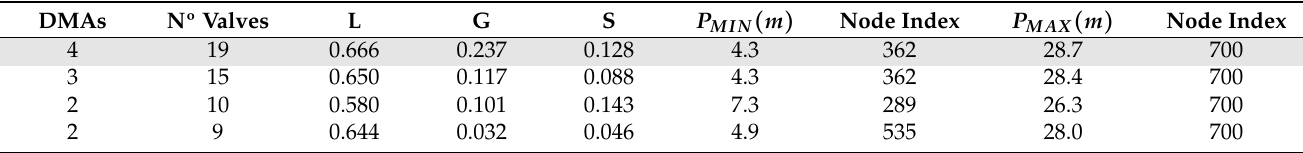
Table 5. Operating conditions of each solution obtained with Gini coefficient for MLN network. The gray background corresponds to the solution B represented in Figure 10.